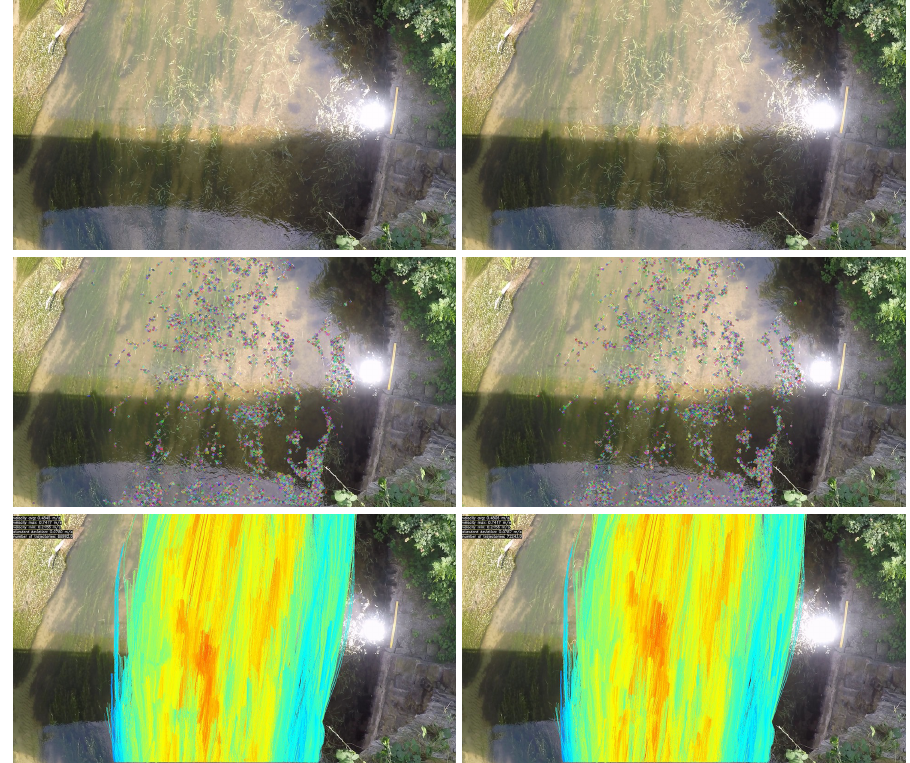
Figure 3. The outcome of OTV on two frames, I t − 1 ( left ) and I t ( right ), of a sequence captured in the Brenta river, in Italy. From top to bottom: input frame, feature points detected by the FAST algorithm highlighted with coloured circles, and estimated trajectories (each colour encodes a different velocity—The warmer, the